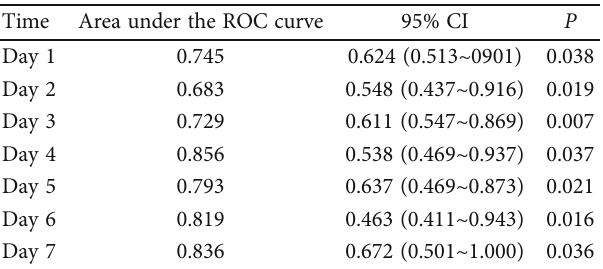
Figure 3: Changes of RRI between the AKI group and the non-AKI group. ∗ meant that the di ff erences between the groups were statistically considerable, P < 0.05 . Table 2: Area under the ROC curve analysis of RRI for the diagnosis of AKI at di ff erent times of ICU